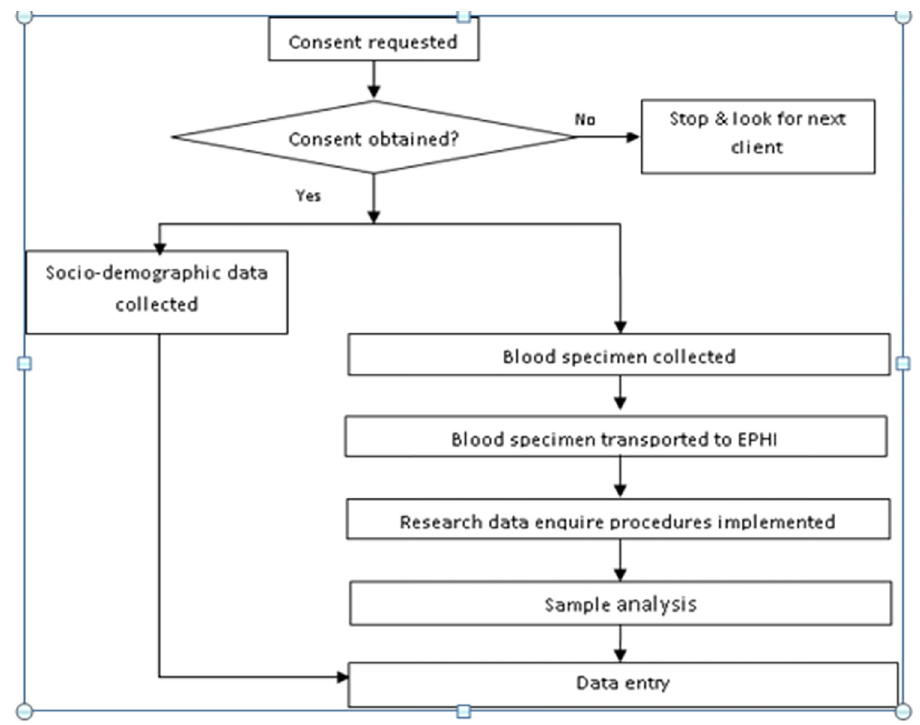
Fig 1. Specimen and data collection flow chart.